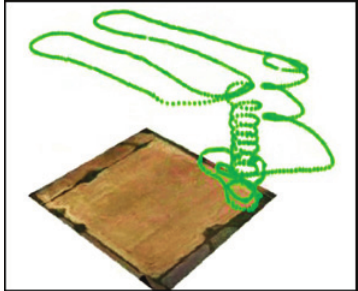
Fig. 5. Three-dimensional flight circuit example (Images … 2011)